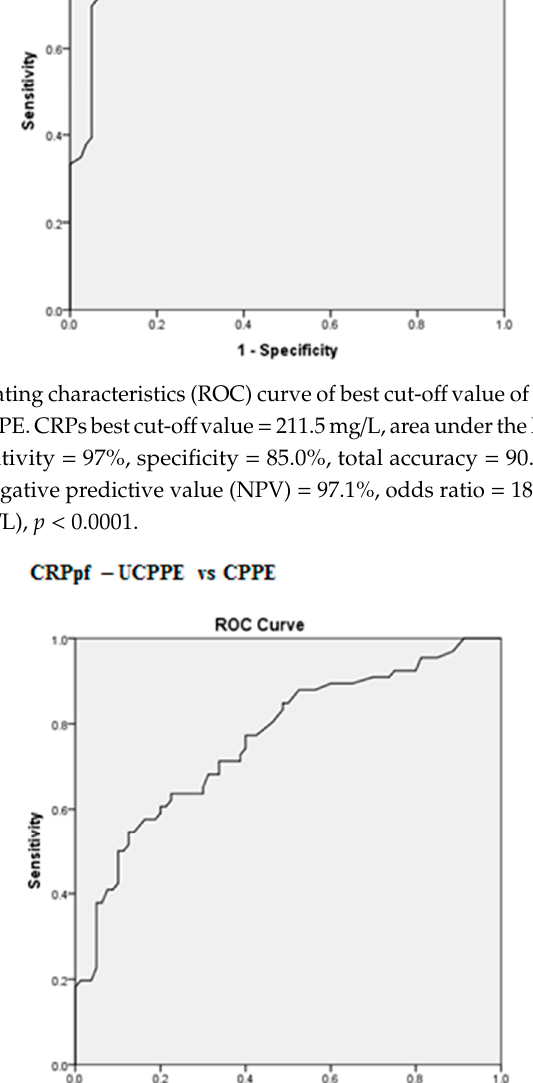
Figure 5. ROC curve of best cut-off value of CRPpf for discrimination between UCPPE and CPPE. CRPpf best cut-off value = 90.5 mg/L, AUC = 76.3% (95% CI: 68.5–84.1), sensitivity = 57.6%, specificity = 83.8%, total accuracy = 72%, PPV = 74.5%, NPV = 70.5%, odds ratio = 6.9 (risk for CPPE when CRPpf value > 90.5 mg/L), p < 0.0001.